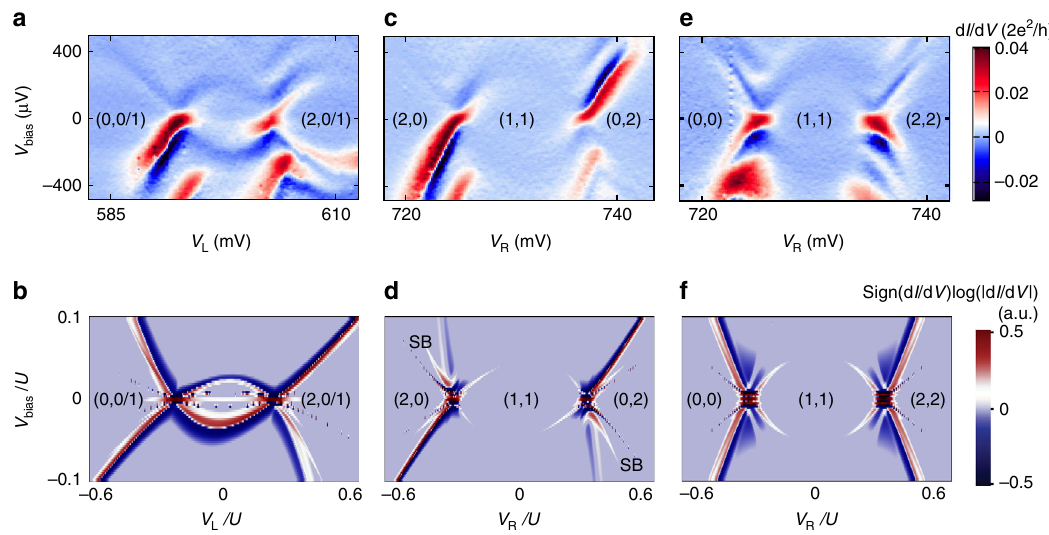
Fig. 3 Bias spectroscopy of Andreev molecular states. a , c , e Source-drain bias spectroscopy along various cuts depicted by the dashed-line arrows in Fig. 2c, i.e., right dot is fi xed to 0/1 degeneracy point and left dot is swept in a , along detuning in c , and along energy level shift axis in e (see additional complementary data in the Supplementary Fig. 4). Both V L and V R are tuned in each panel, but either V R or V L is used to denote the x -axis. Parity con fi gurations indicated in brackets in each region. b , d , and f , Corresponding numerically computed differential conductance as function of left dot chemical potential with fi xed right dot chemical potential b , along detuning d and energy level shift axis f . “ SB ” s in d mark the numerically reproduced spin blockade corners at positive and negative